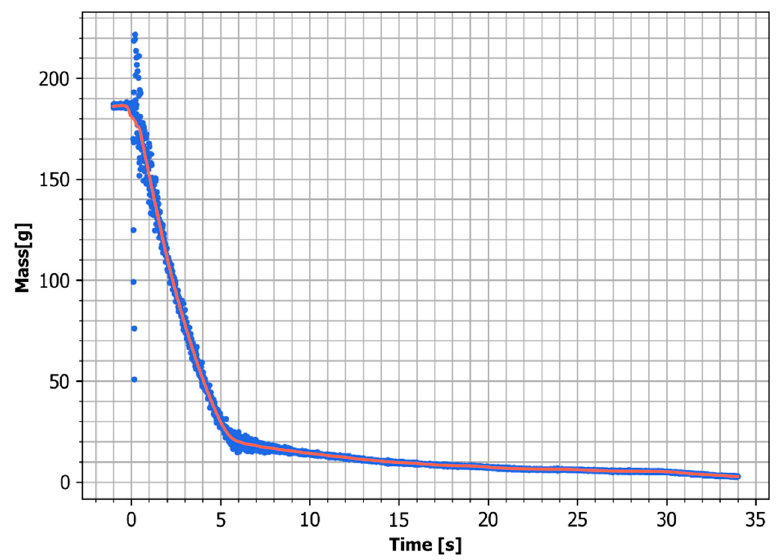
Figure 5. Run tank mass time history of a typical test. The valve opens at approximately 0 s. Scattered data can be seen during the initial phase. Data for the Injector No. 2.